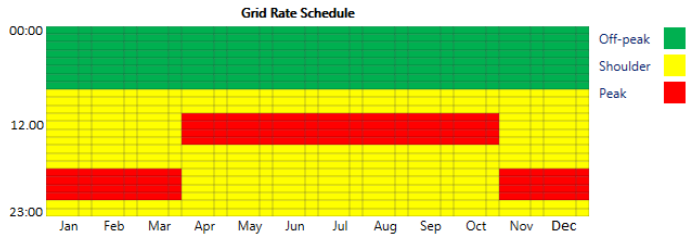
Figure 5. Rate schedule implemented in HOMER